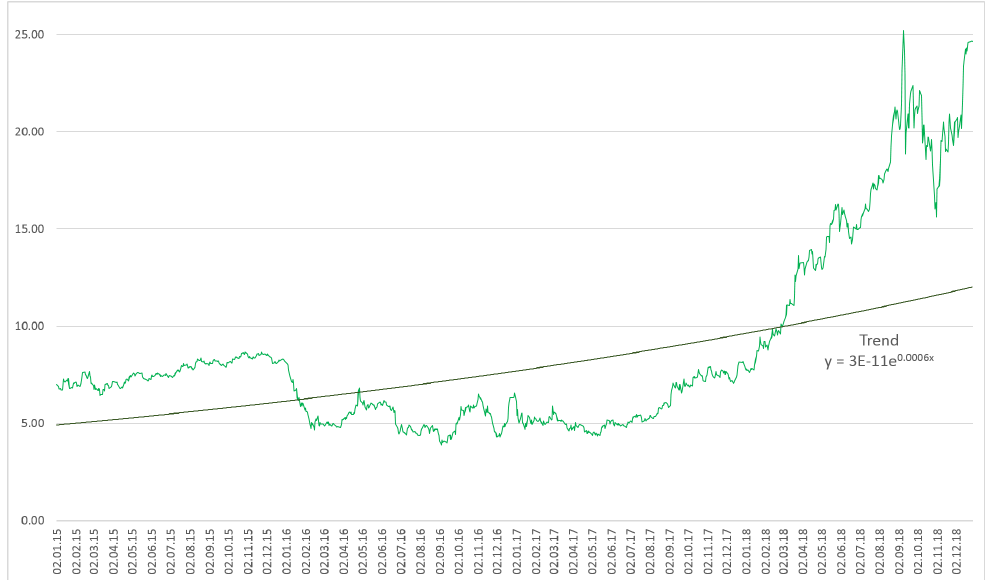
Figure 4. Daily development of the CO 2 price, 1 January 2015–31 December 2018 with an exponential trend. Source: